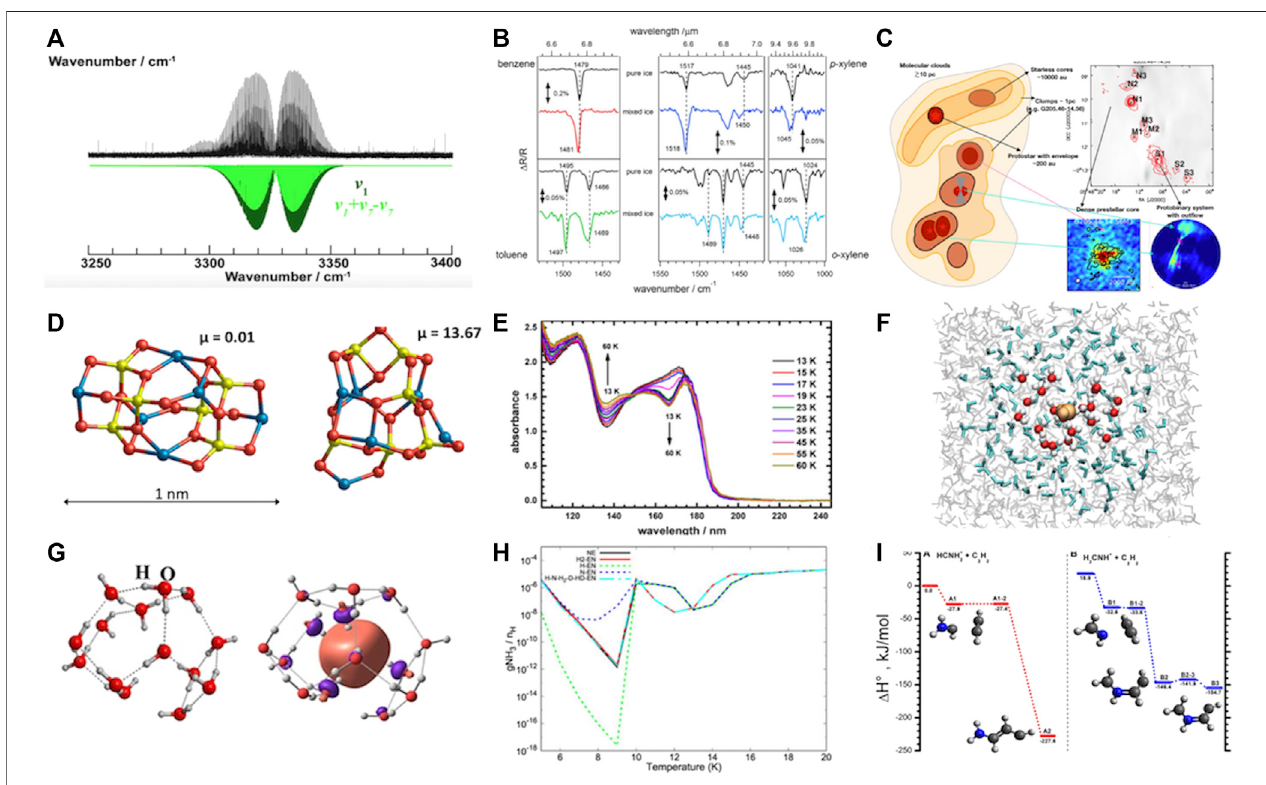
FIGURE1| (A) Jiangetal.; (B) Salteretal.; (C) Sahuetal.; (D) MarinosoGuiuetal.; (E) Loetal.; (F) Du fl otetal.; (G) Rimolaetal.; (H) Dasetal.; (I)